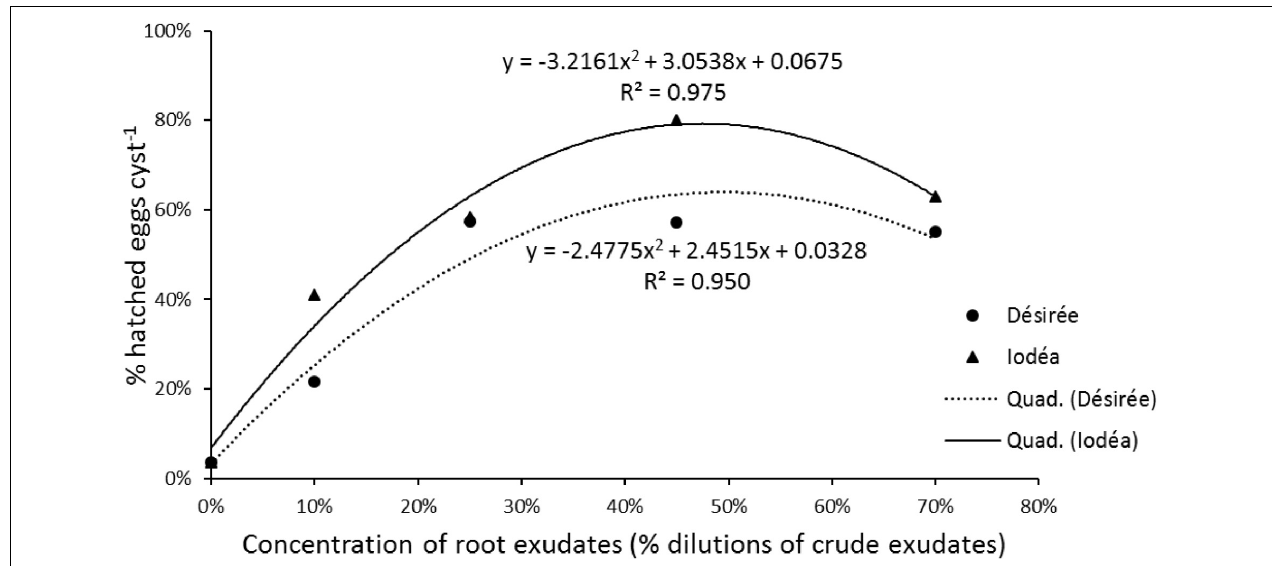
FIGURE 1 | The relationships between in vitro hatching of Globodera pallida and concentration (0, 10, 25, 45, or 70%) of the crude root exudates of Solanum tuberosum var. Désirée or Iodéa. The regression coefficient ( R 2 ) and equations of the quadratic model are indicated for each potato variety. Data points represents means values of six replicates.